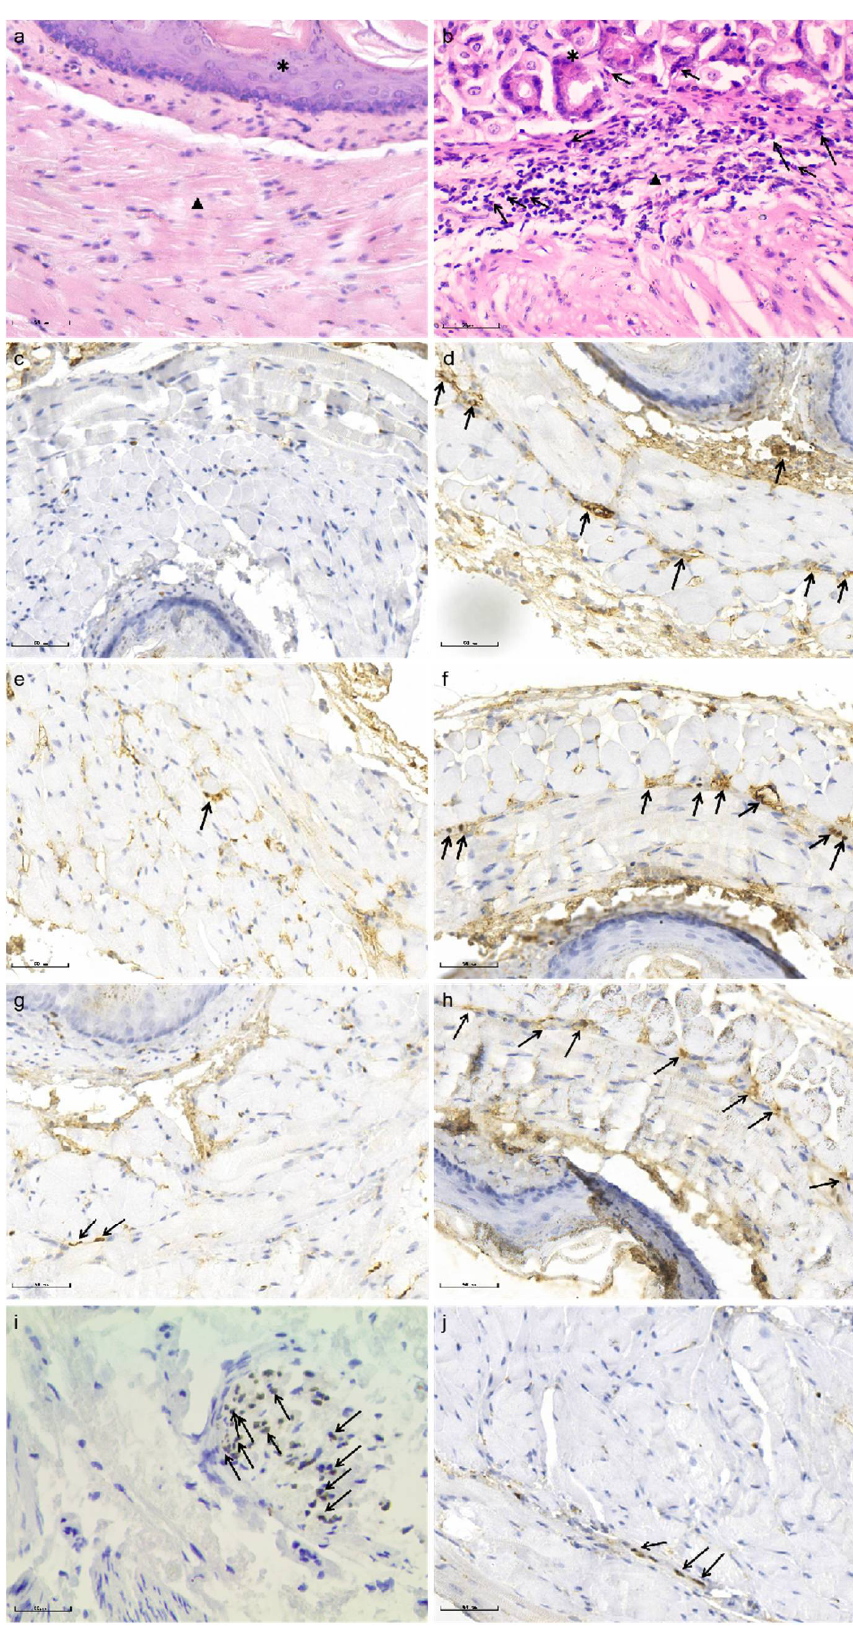
Figure 7. Immuno-histochemical staining of the esophageal tissue of mice in control and model group at D35. ( a , b ) HE staining of the esophagus, which shows eosinophils in model group ( b ) out- numbered that in control group ( a ) in both mucosa and muscularis propria. * Indicates mucosa, ▲ indicates muscularis propria, black arrows indicate eosinophils. ( c – h ) Immuno-histochemical stain- ing showed more MBP, ECP and EDN positive cells in the esophageal smooth muscle of mice in